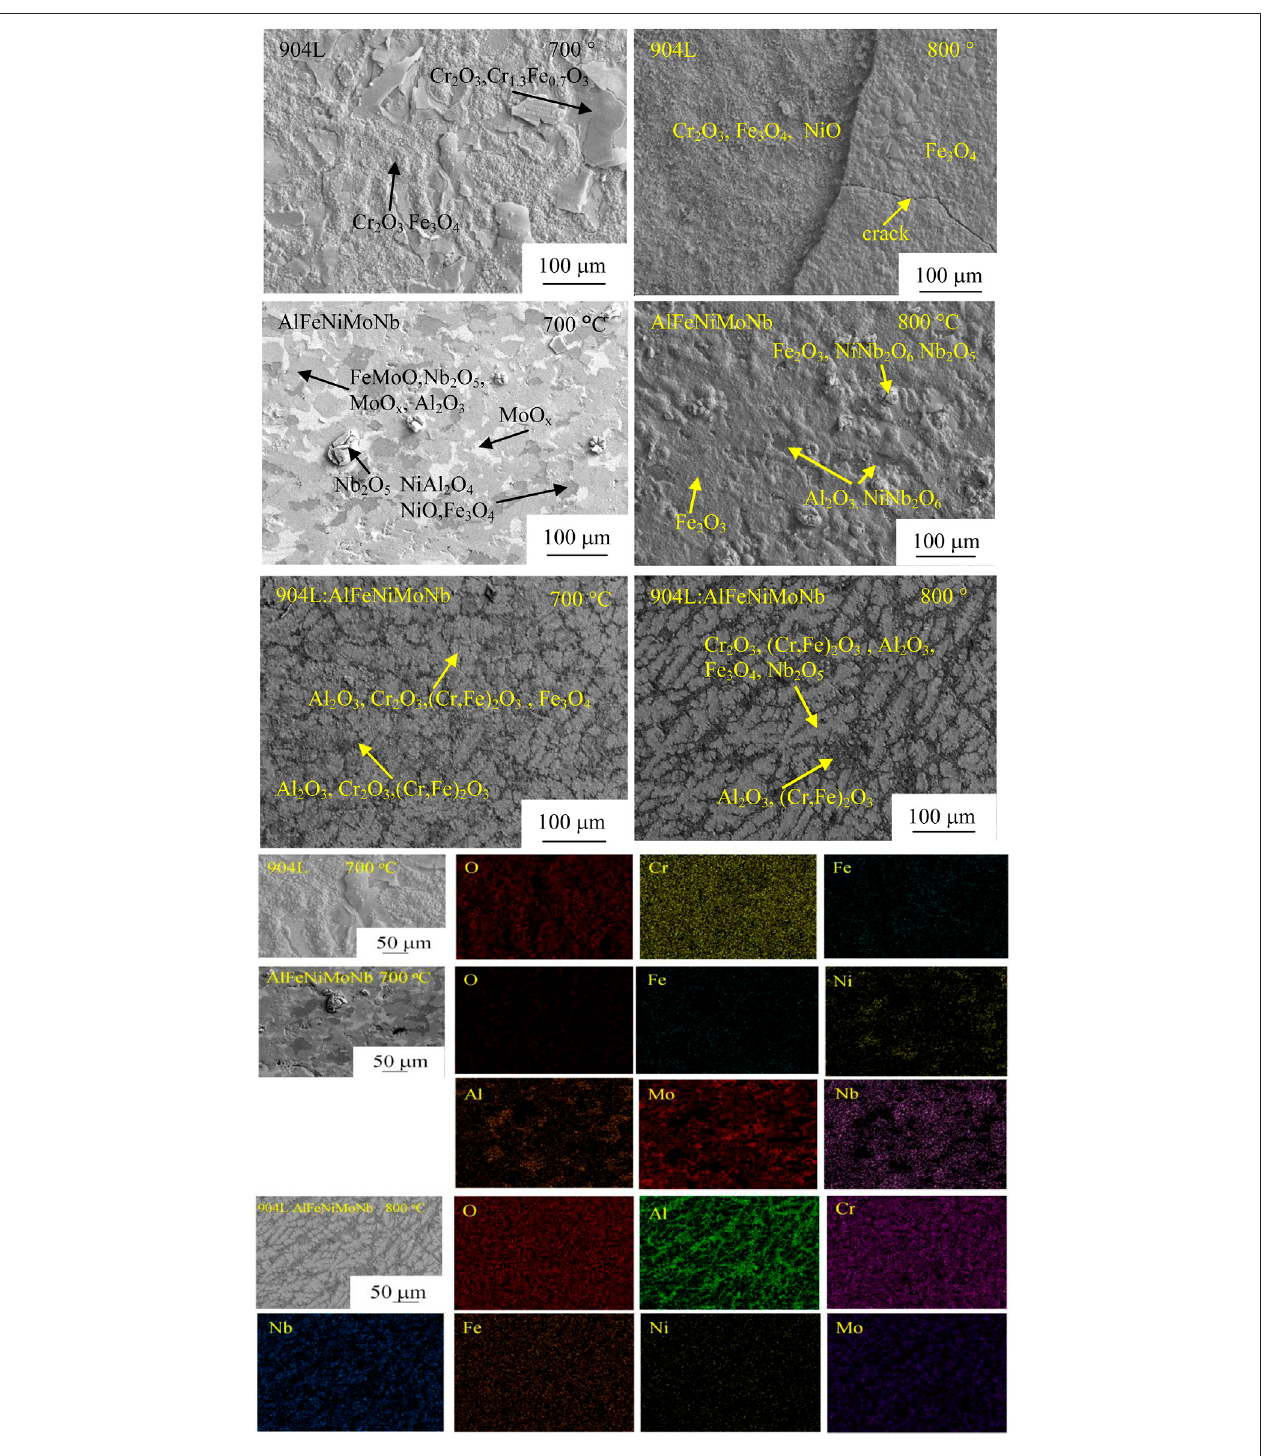
FIGURE 10 | Surface morphology and composition of alloys after high-temperature chloride corrosion at 700 ° C and 800 ° C for 55 h under N 2 – 2.6 vol.% CO 2 – 1.3 vol.% O 2 – 2,700 vppm HCl gaseous environment.